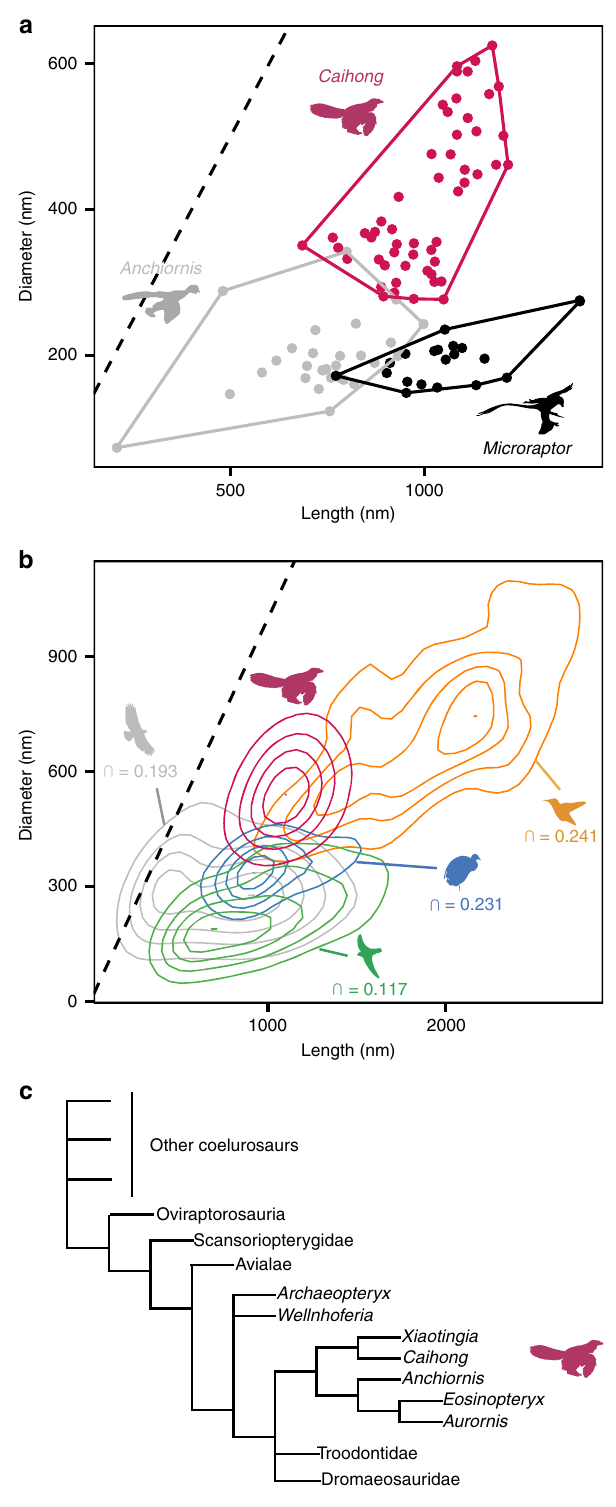
Fig. 6 Analyses of nanostructure shape diversity and phylogenetic position of Caihong juji . a Mean length and diameter measurements for nanostructures from various body regions in Caihong juji (red), Anchiornis huxleyi (grey) and Microraptor (black). Rarefaction analyses show that sampling of the fossil taxa is appropriate to determine signi fi cant differences: Anchiornis shows signi fi cantly more nanostructure diversity than either Caihong or Microraptor (Supplementary Fig. 13). b Morphospace plots of raw nanostructure measurements for Caihong juji relative to extant avian groups with platelet-like melanosomes (orange: hummingbirds, green: swifts, blue: trumpeters and trogons, grey: other non-platelet avian melanosomes). Contour lines show 2D density of measurements. Numbers give proportional overlap ( ∩ ) between Caihong juji (red) and each group (Methods). c Simpli fi ed coelurosaurian phylogeny (strict consensus of 192 most parsimonious trees from the primary analysis) showing the recovered position of Caihong juji (Supplementary Note 3; Supplementary Figs. 18